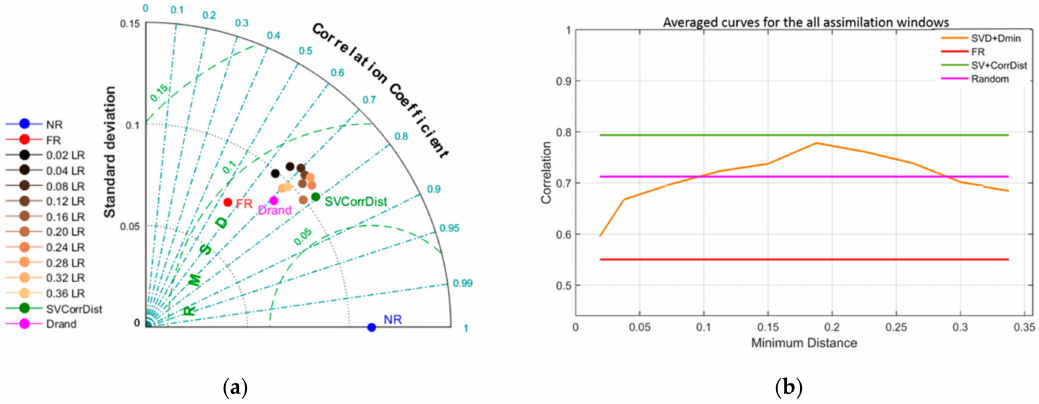
Figure 11. Taylor’s diagram ( a ) and correlation graph ( b ) of the average statistics of the analyses obtained for all assimilation windows. Each case corresponds to a network configuration defined by the highest SVs and the minimum fixed distance, expressed as a fraction of the Rossby deformation radius. The green point and the green line correspond to the case of a variable distance on the correlation